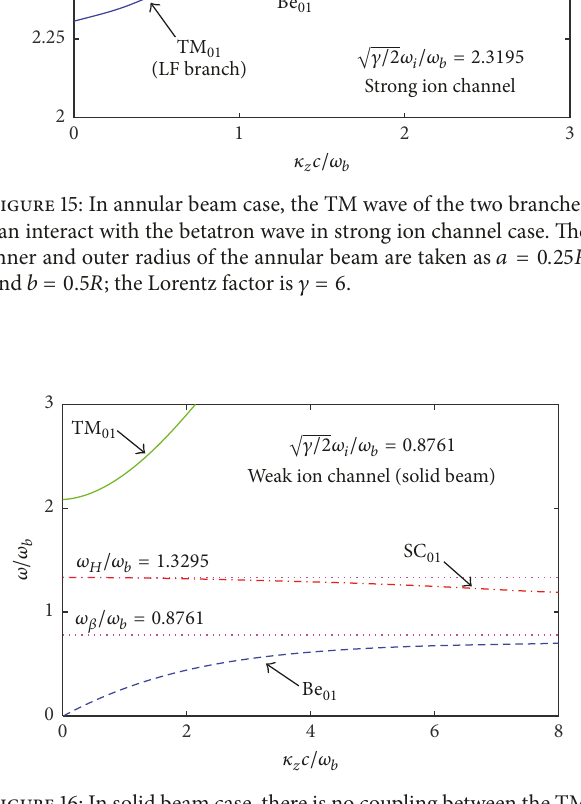
Figure 16: In solid beam case, there is no coupling between the TM and ES waves in weak ion channel case. The beam radius is taken as 𝑎 = 0.25𝑅 ; the Lorentz factor is 𝛾 = 6 .